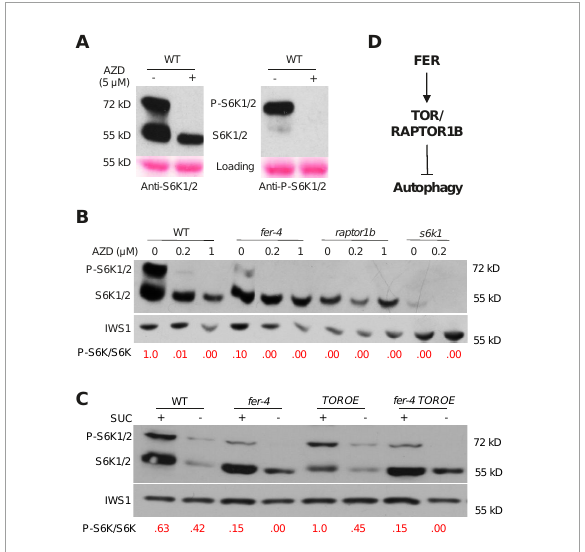
FIGURE7 S6K1/2 phosphorylation by TOR was decreased in fer-4 mutant. (A) Western blot showing testing of anti-S6K1/2 and anti-P-S6K1/2 (phosphorylated S6K1/2) antibodies in WT with or without 5 µ M AZD8055 for 3 h. Ponceau S staining was used as loading control. (B,C) Western blot showing phosphorylated and non-phosphorylated S6K1 in 10-day-old seedlings of